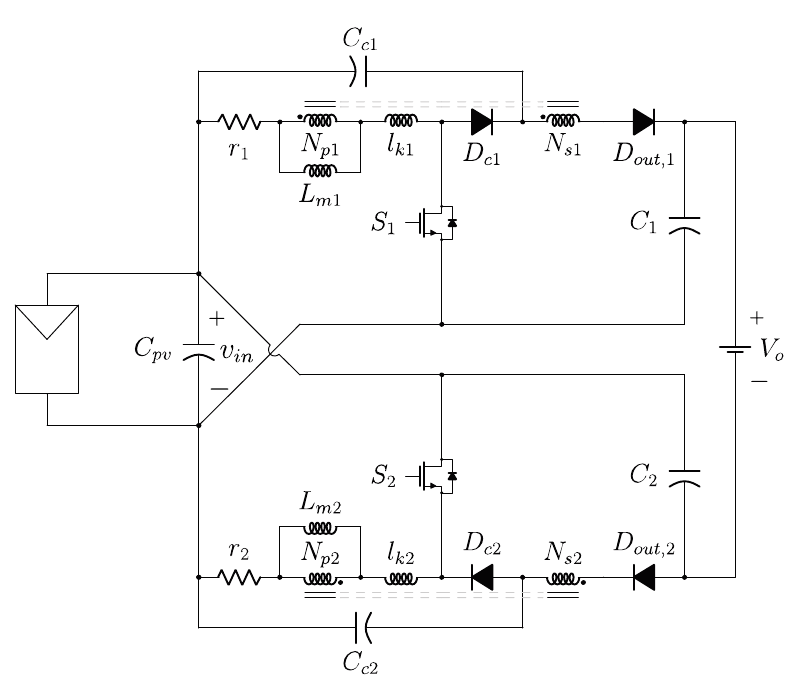
Figure 1. Symmetrical interleaved coupled-inductor-based boost